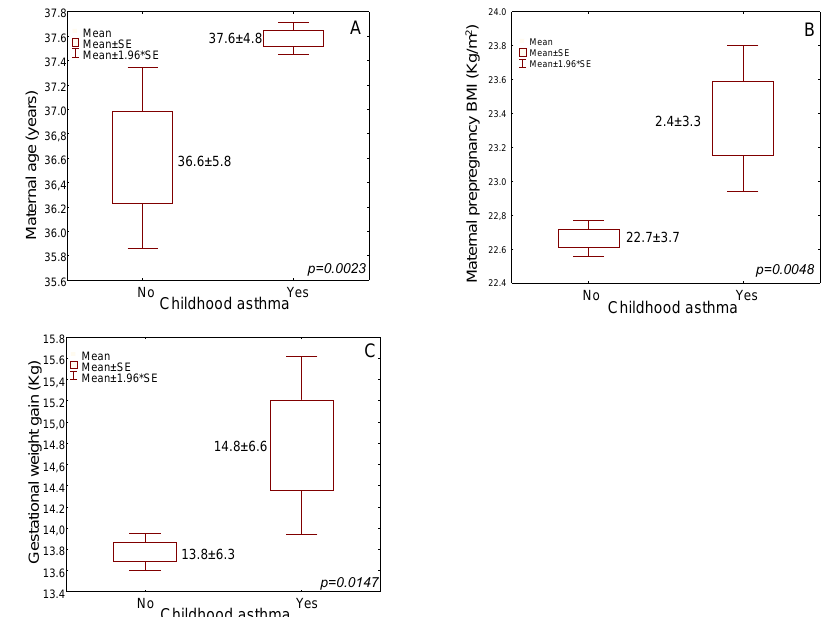
Figure 2. Box-whisker box plots of childhood asthma in association with ( A ) mothers’ age, ( B ) moth- ers’ BMI before gestation and ( C ) body weight gain during gestation . Table 1. Associations of childhood asthma with maternal sociodemographic, anthropometric and prenatal and perinatal factors.